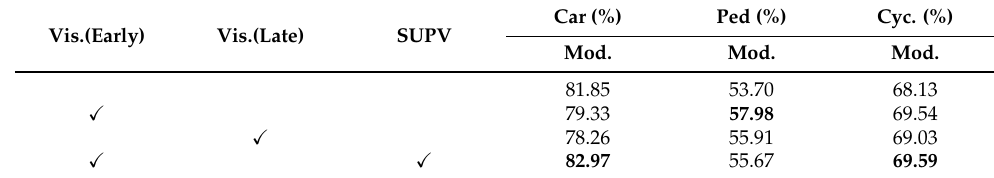
Table 10. Comparison of spatial visibility fusion strategies; vis.(early) indicates visibility feature in early fusion while vis.(late) is for late fusion. SUPV is short for the supervised-PointRendering. The AP is calculated with 11 recall points.